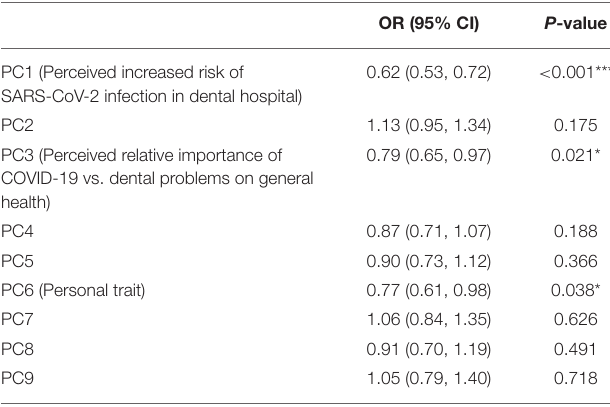
TABLE 4 | Multivariable associations between principal components of psychological factors and dental avoidance.